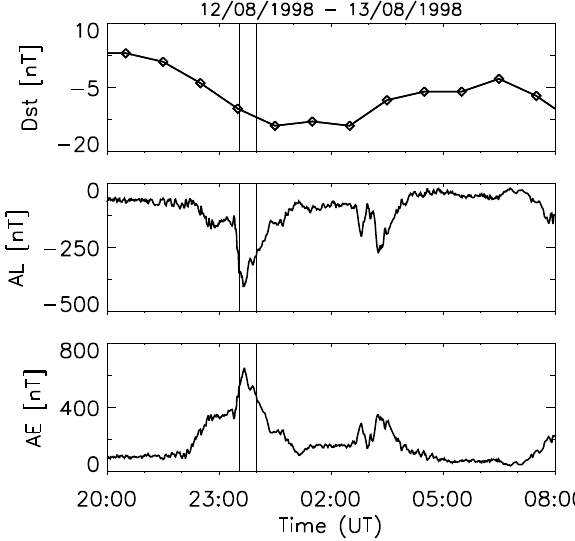
Fig. 8. The AE, AL and D st -indices between 20:00 and 08:00 UT on 12–13 August 1998. The two vertical solid lines indicate our time interval with data between 23:30 and 23:55 UT. Fig.8. TheAE,ALand Dst-indices between 2000 and0800 UTonAugust 12-13, 1998. Thetwo vertical solid lines indicate ourtime interval withdata between 2330 and 2355 UT. the outer black box corresponding to the PIXIE